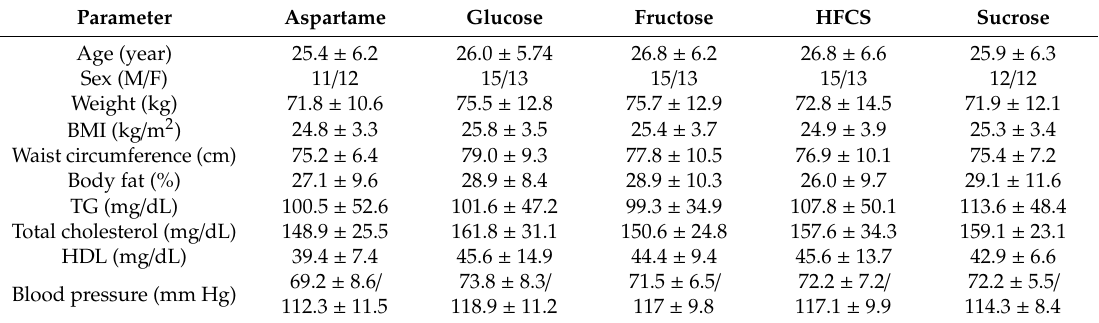
Table 1. Description of participant characteristics at Week 0 by sugar-sweetened beverage group 1